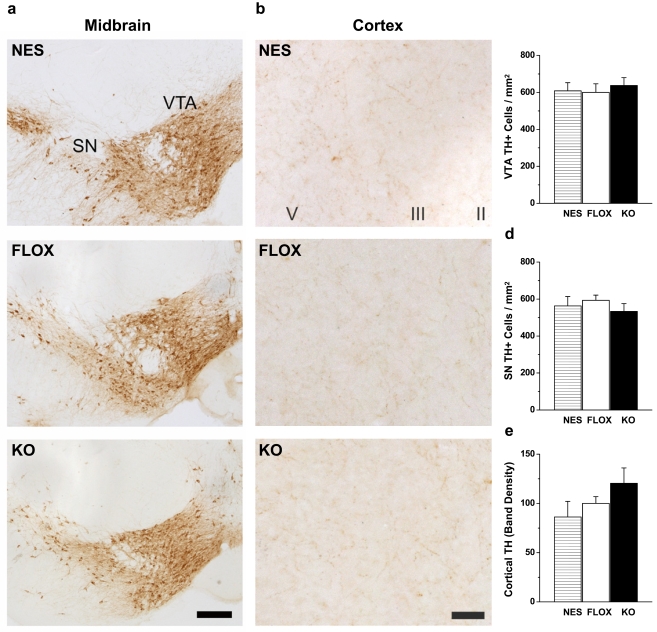
TH staining and expression in the midbrain and cortex is similar in NES, FLOX, and KO mice.TH immunoreactivity in the (A) midbrain substantia nigra (SN) and ventral tegmental area (VTA) and the (B) cortex. Scale bars = 50 µm. Coronal brain sections were stained with TH antibody and cell counts of TH+ cells were taken. Cell counts are similar in NES, FLOX, and KO matched mice in both the (C) VTA and the (D) SN. Mean±s.e.m TH+ cells/mm2 are shown; n = 6. (E) TH protein levels in the cortex. Mean±s.e.m optical densities are shown as a percentage of FLOX control mice; n = 19–22. One-way ANOVA analysis reveals no significant difference between genotypes.